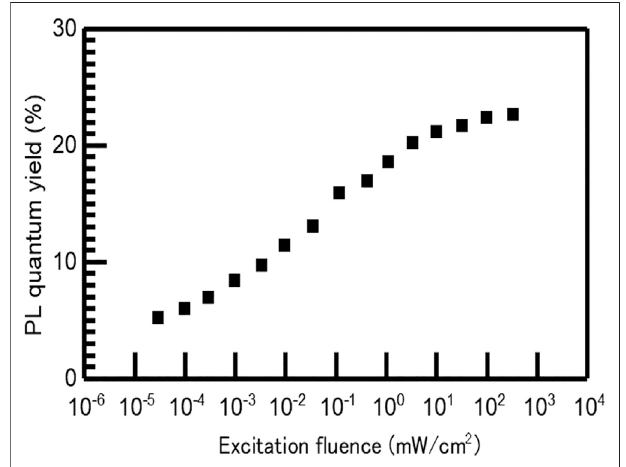
FIGURE 3 | Absorption and PL spectra of MA 0.6 FA 0.4 PbI 2.8 Br 0.2 perovskite fi lms.